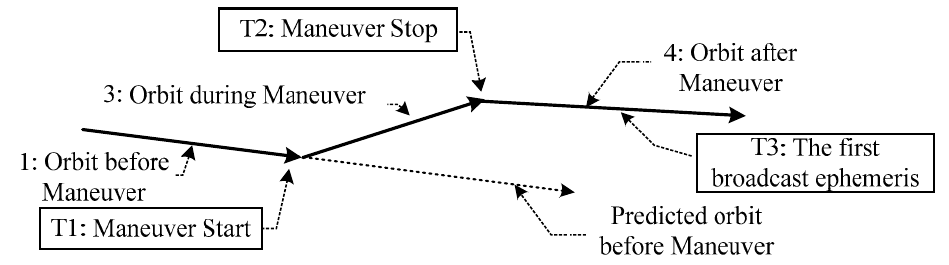
Figure 10. The orbit change before and after the orbit maneuver.